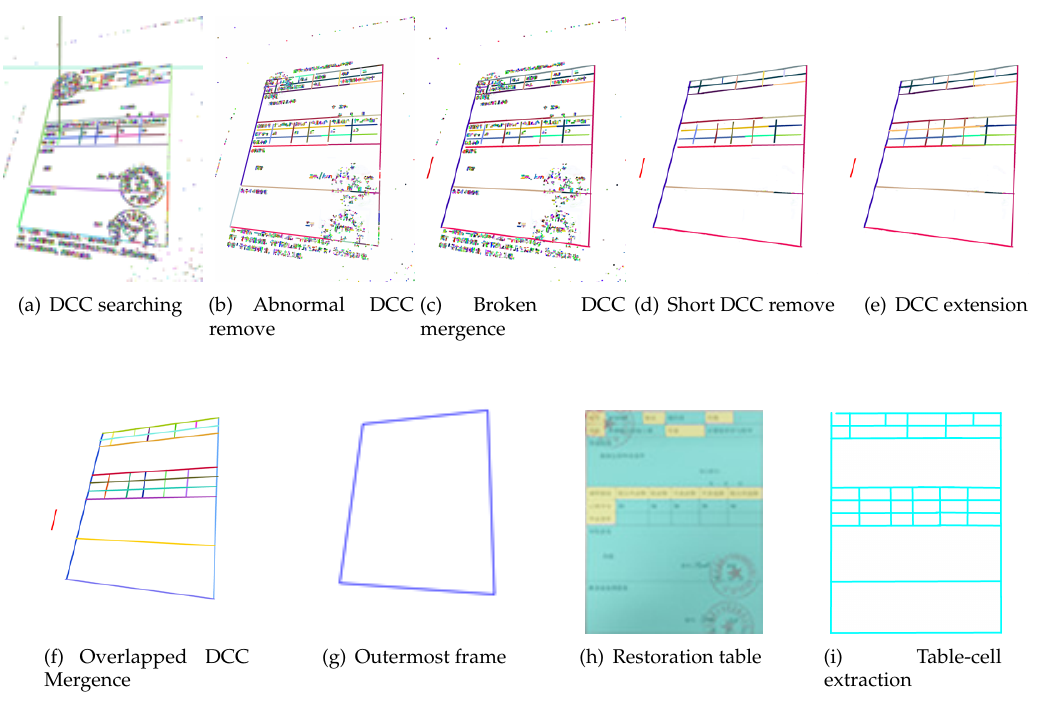
Figure 5. Recognition result of each